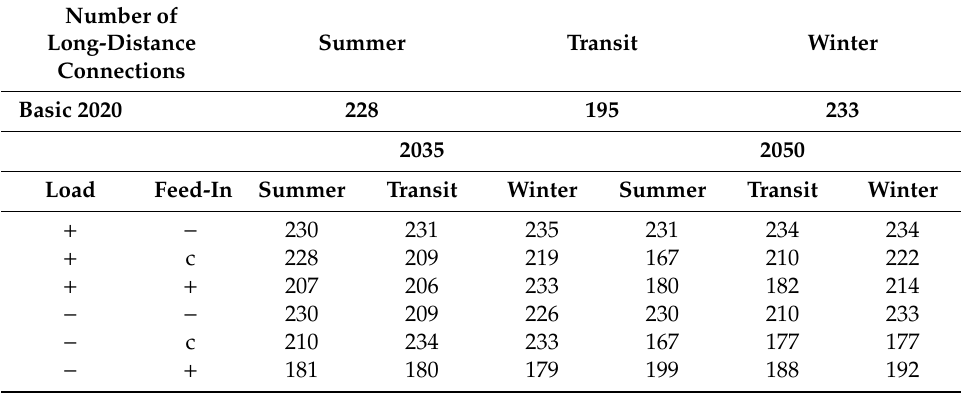
Table 10. Number of long-distance connections.